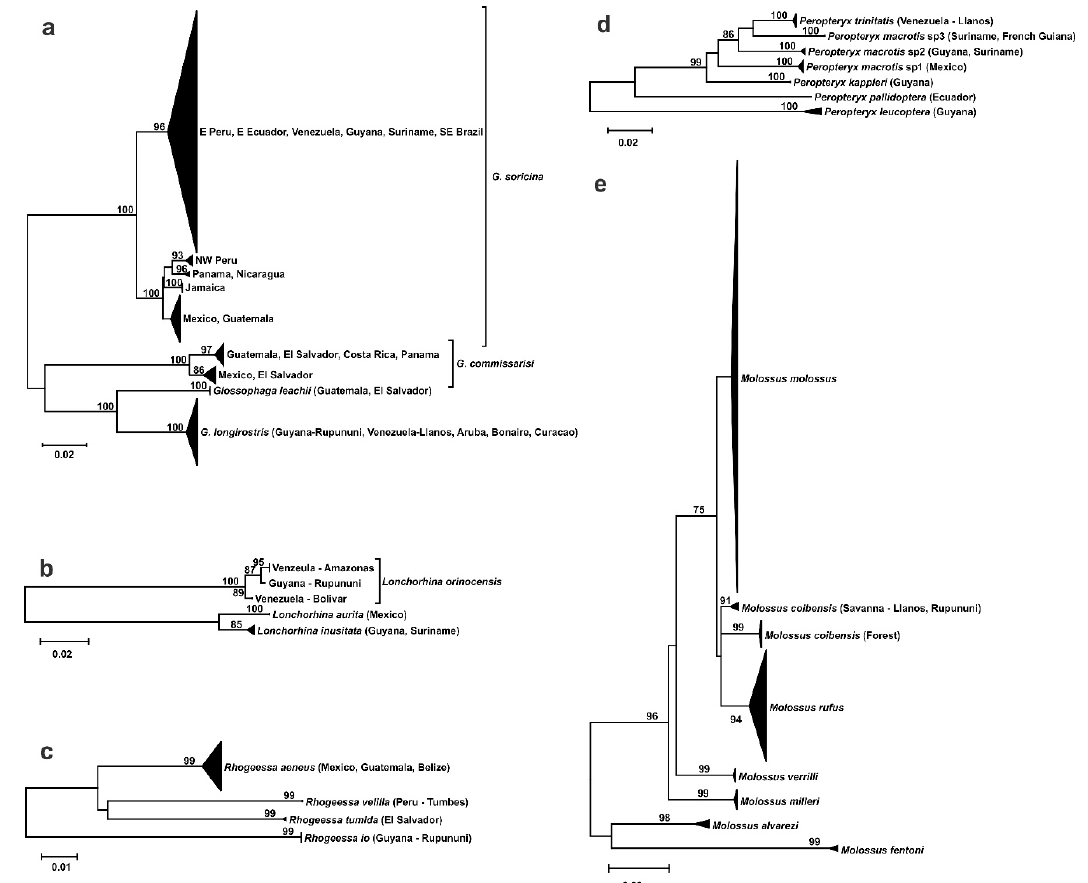
Figure 4. DNA barcoding trees of bat taxa with endemism in the Guianan savannas: ( a ) Glossophaga , ( b ) Lonchorhina , ( c ) Rhogeessa , ( d ) Peropteryx , and ( e ) Molossus .